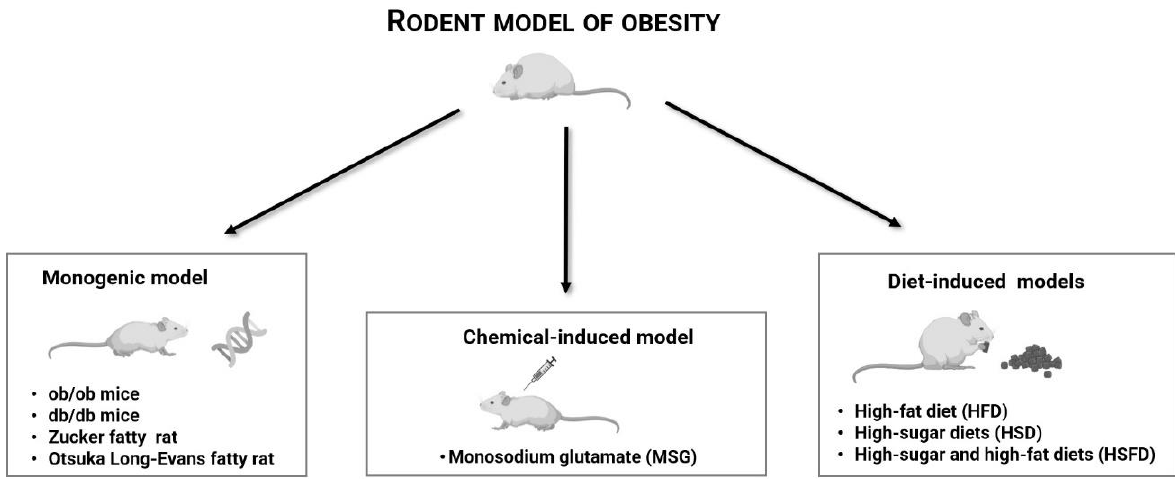
Figure 2. Rodent models of obesity that can be applied to natural compounds research.